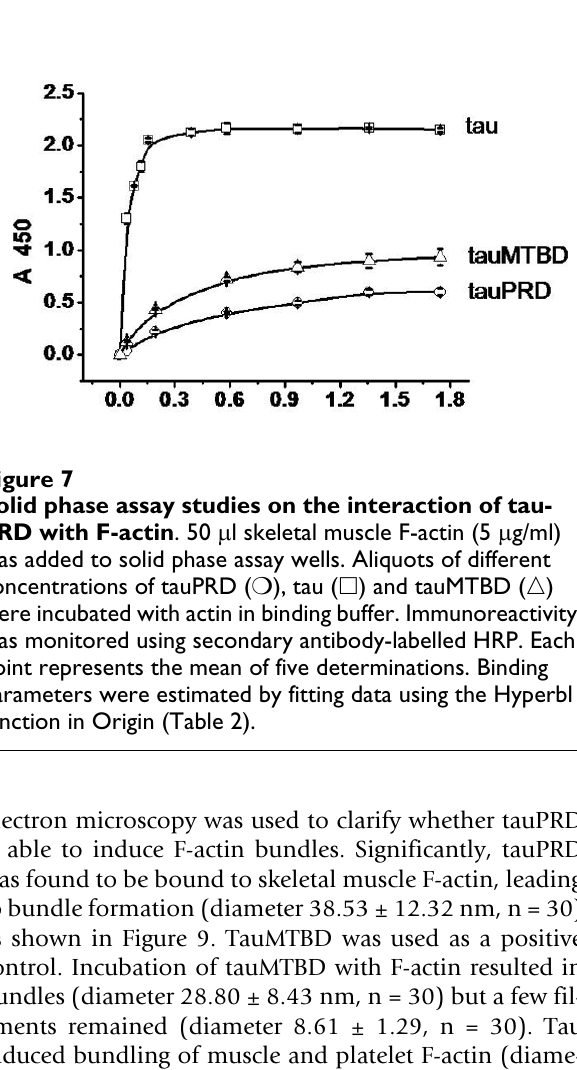
Table 2: Biochemical Binding Parameters from Solid Phase Assays Tau